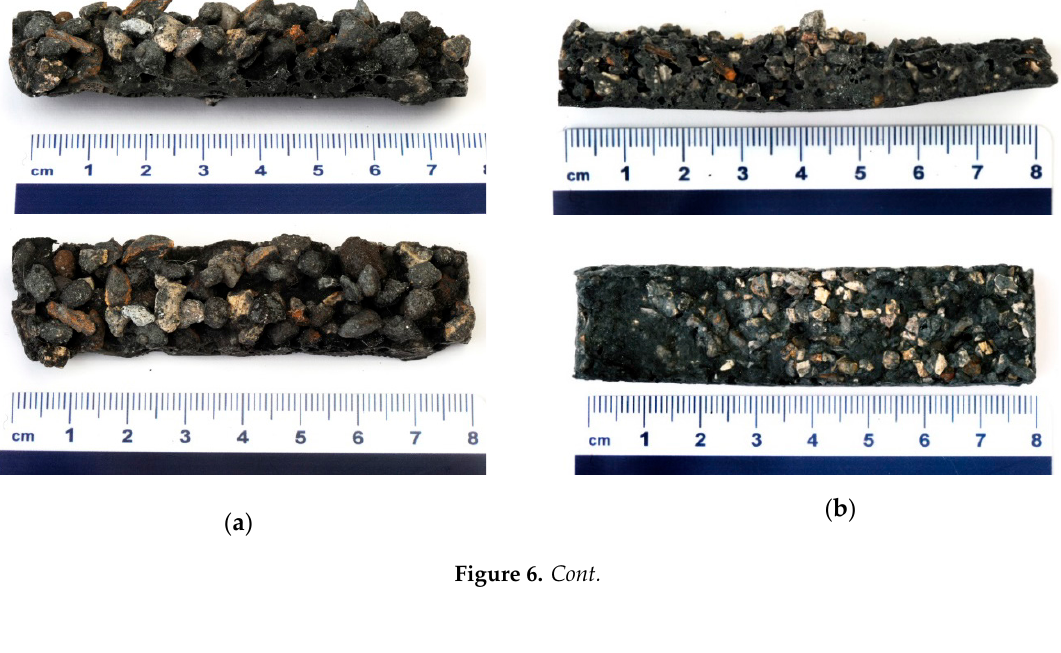
Figure 5. Rietveld refinement of precursor’s fraction ( a ) above 4 mm, ( b ) between 2 mm and 4 mm, ( c ) between 1 mm and 2 mm and ( d ) below 1 mm.